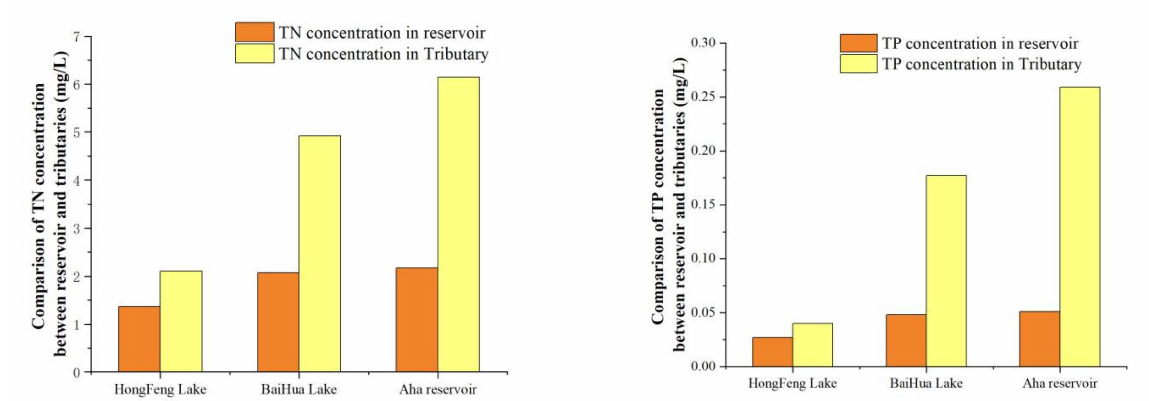
Figure 7. TN ( left ) and TP ( right ) concentrations in the reservoir and